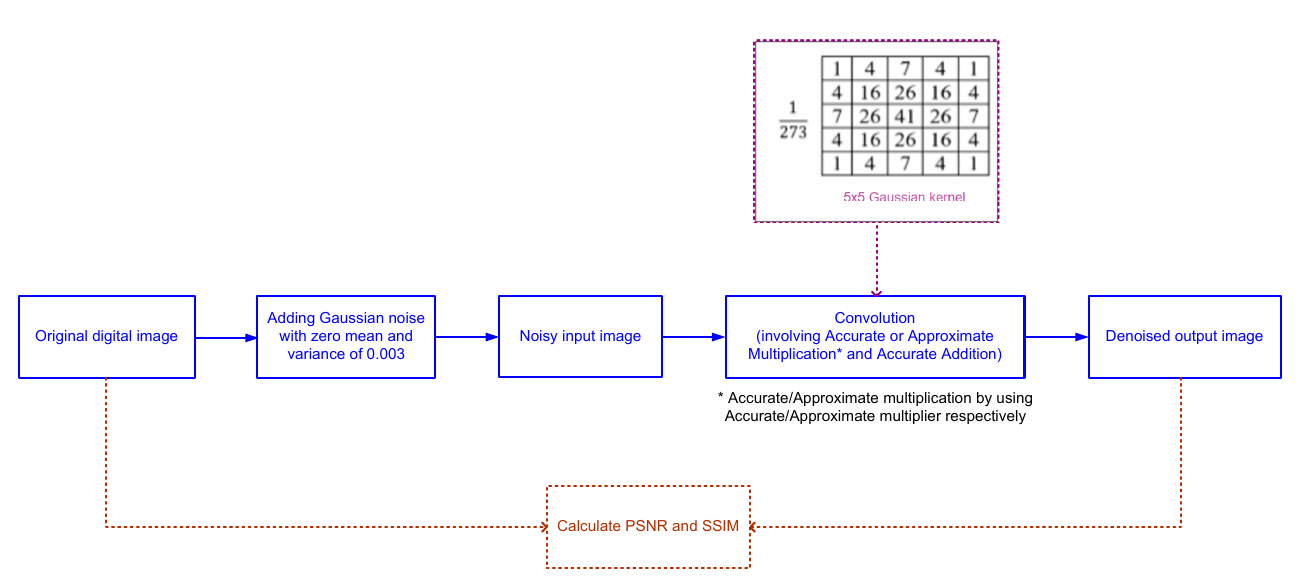
Figure 5. Block diagram of digital image denoising.